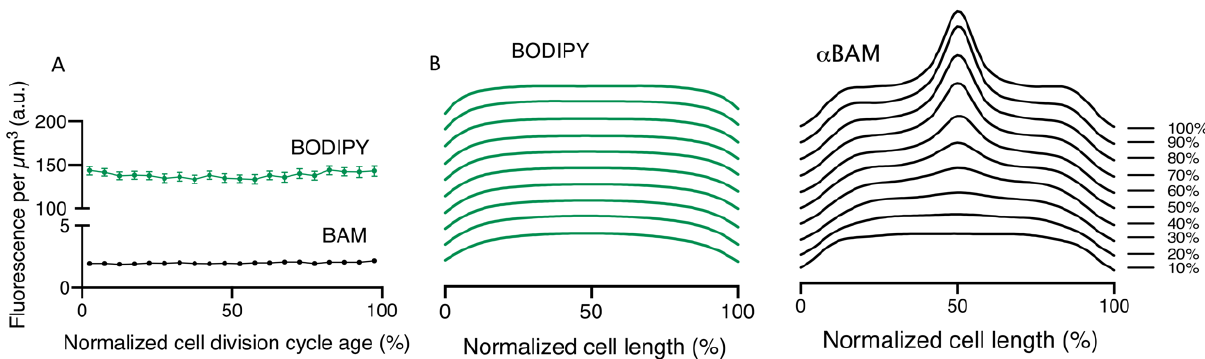
Figure 3. Midcell occurrence of BAM and Bodipy C-12. ( A ) LMC500 wild type cells grown to steady state at 28 ◦ C, stained with the membrane staining Bodipy-C12 (green) and with antibodies against the BAM (black). The concentration of the fluorescent signals of both the membrane (green) and the BAM (black), plotted as function of the normalized cell division cycle, show a constant concentration over time. ( B ) The fluorescence profiles were binned into 10 age classes (10% to 100%) and plotted as function of the normalized cell length. The BAM complex exhibits an enrichment at midcell, in correspondence to 40% of the cell division cycle age. The membrane staining does not change in distribution during time. BAM and Bodipy-C12 (n = 1956).